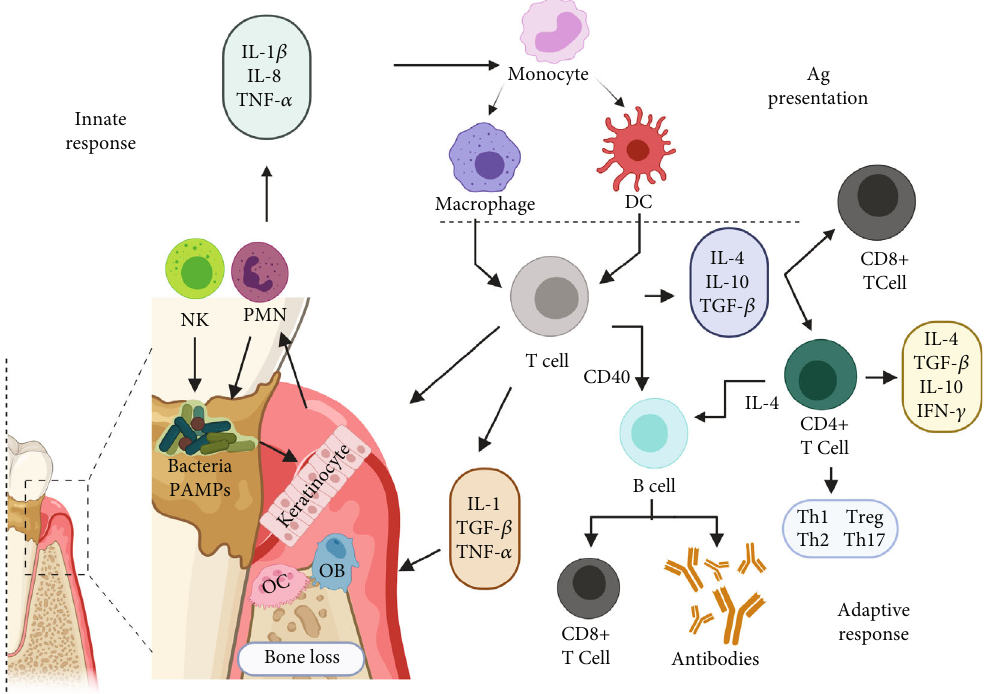
Figure 1: Innate immune cells, including keratinocytes, polymorphonuclear cells (PMNs), antigen-presenting cells (APCs), and natural killer (NK) cells, hold pathogen recognition receptors (PRRs) that detect pathogen-associated molecular patterns (PAMPs) present in bio fi lm bacteria, and these interactions promote the acute in fl ammatory response. Antigen-presenting cells (APCs) phagocytose pathogens, process antigens, and present the antigens in the form of peptides displayed by major histocompatibility complex (HLA) molecules. Costimulatory molecules stabilize this interaction. APCs migrate to secondary lymphoid tissues where they activate adaptive immune cells, including CD4 + T cells, such as Th1, Th2, and Th17 cells; cytotoxic CD8 + T cells; and B cells that will mature into antibody-producing plasma cells. Created with BioRender.com